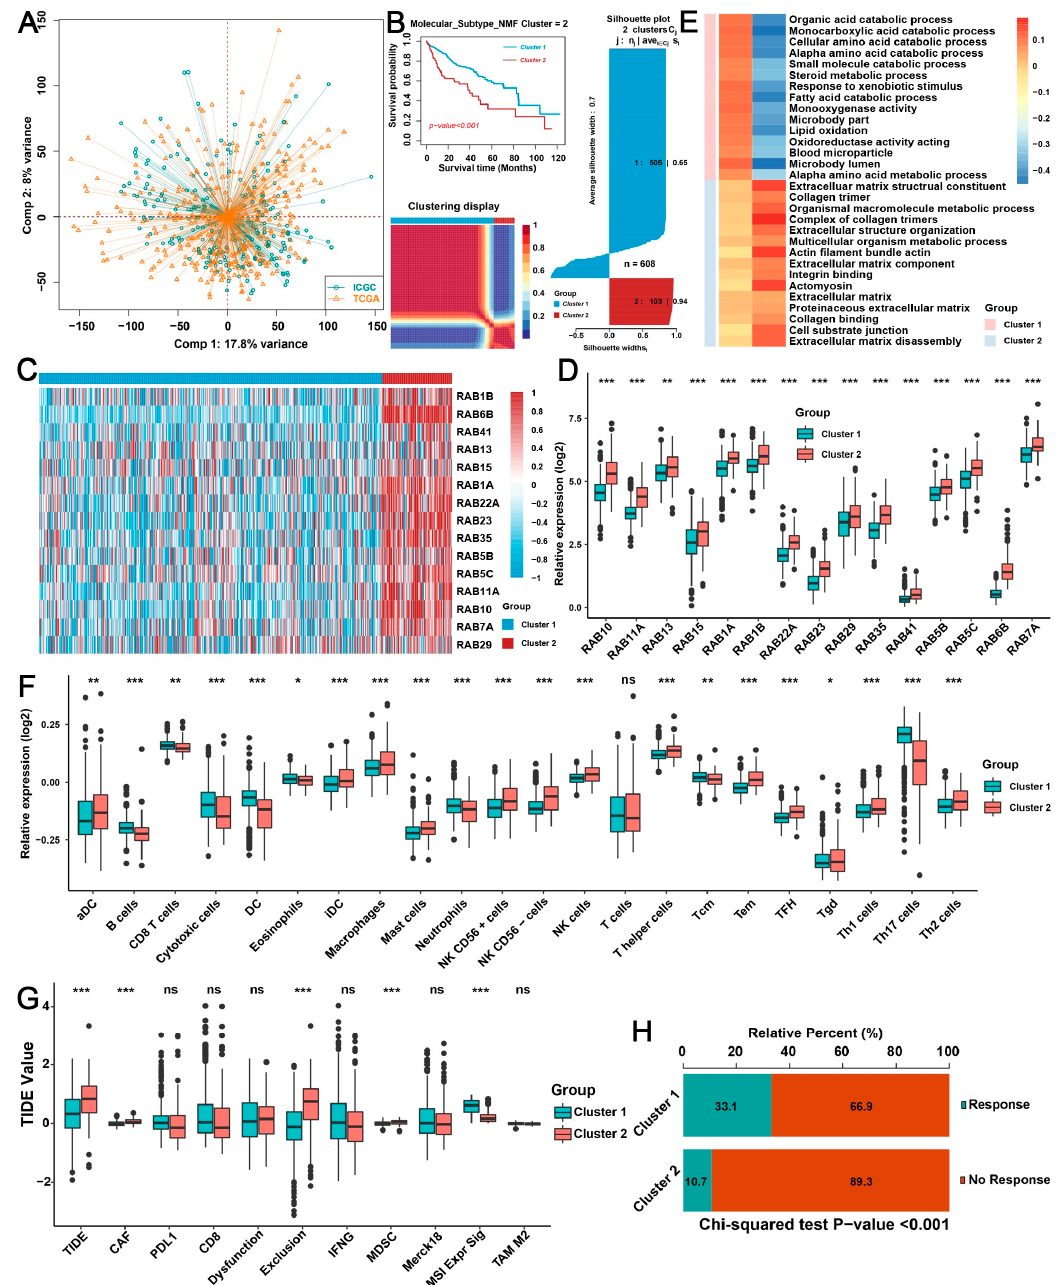
Figure 2. Clustering HCC based on the 15 RAB family genes by NMF analysis. ( A ) Principal component analysis (PCA) of the transcriptome profiles in the pooled HCC cohort from the TCGA and ICGC databases. ( B ) HCC samples were clustered by the NMF method. Kaplan–Meier survival curve for comparing the OS among two clusters by the “CancerSubtypes” package (upper panel). Two RAB clusters by PCA (lower panel). Silhouette width plots of NMF analysis (right panel). ( C ) Heatmap of the 15 critical RAB family genes in the 2 RAB clusters. ( D ) The relative expression of the 15 critical RAB family genes in the 2 RAB clusters from the pooled HCC cohort. ( E ) GSEA annotations for two RAB clusters in the pooled HCC cohort. ( F ) The diversity of immune cell infiltration patterns between patients with various RAB clusters is displayed. ( G , H ) TIDE values of two RAB clusters in the pooled HCC cohort. In ( H ), the chi-square test was used to calculate significant differences. The asterisks represent the statistical p value (* p < 0.05, ** p < 0.01, and *** p < 0.001). ns, no